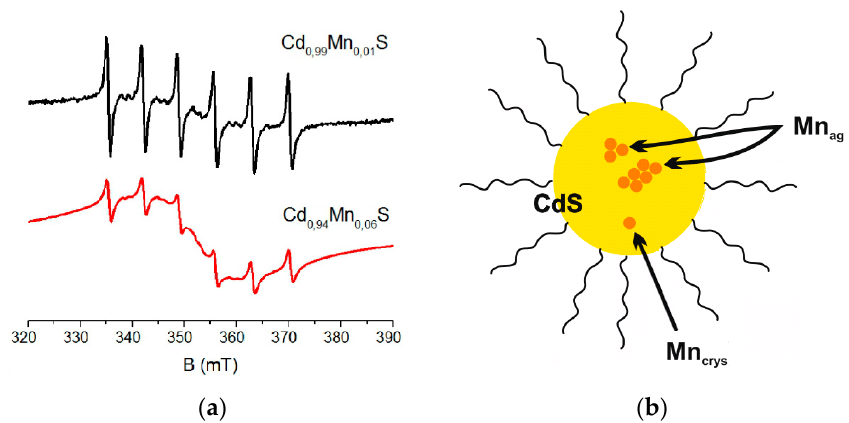
Figure 7. ( a ) EPR spectra of the of Cd 0.94 Mn 0.06 S and Cd 0.99 Mn 0.01 S samples collected 60 min after the start of synthesis. ( b ) The model of Mn ions distribution in the CdS nanoparticles, Mn ag are Mn ions in spin–spin interactions, Mn crys are single Mn ions in the crystal